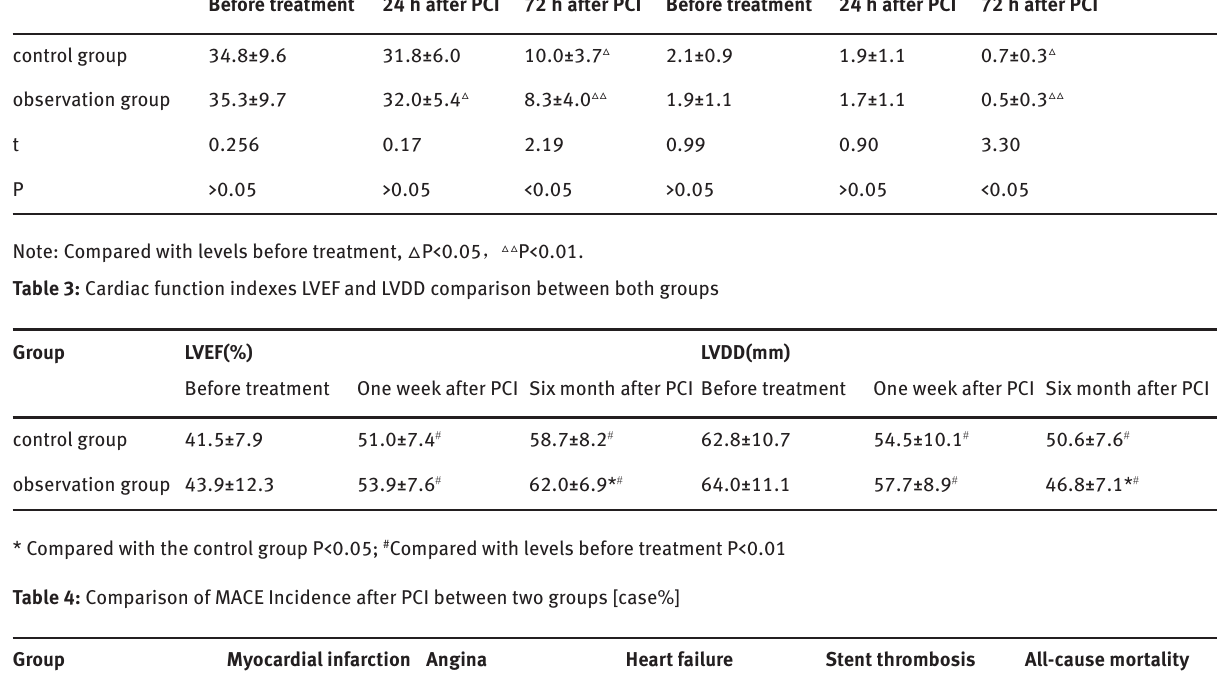
Table 2: Comparison of CK-MB and cTnI between both the groups Group